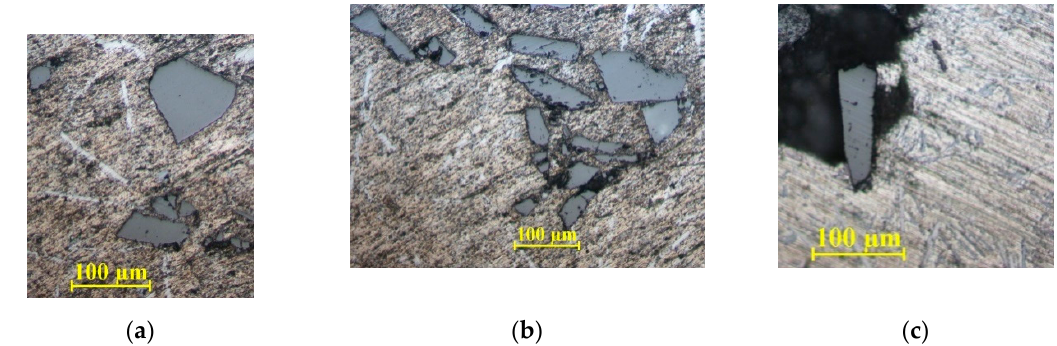
Figure 6. SiC distribution in the metallic base — V 3 . ( a ) Central embedded SiC particle (×200), ( b ) SiC particles agglomeration (×200), ( c ) SiC particle embedded at sample surface (×200).